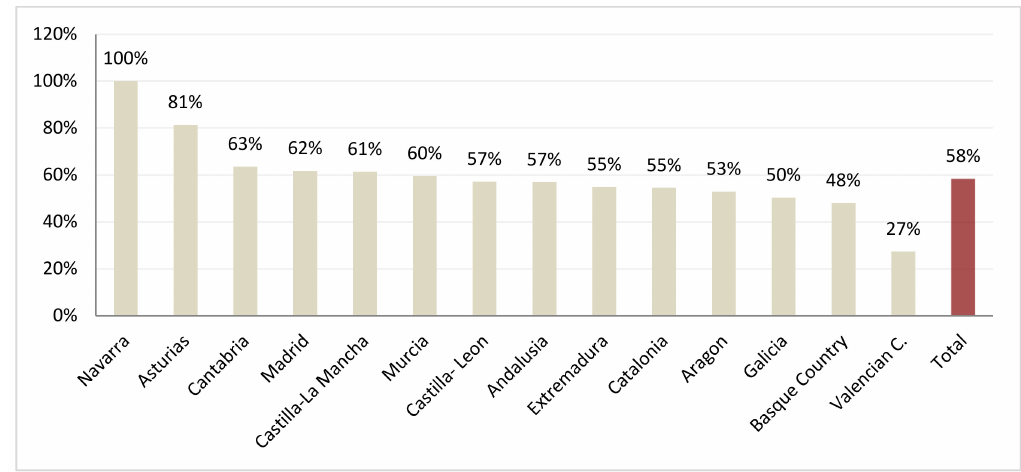
Figure 6. Regional efficiency ranking for cultural tourism.